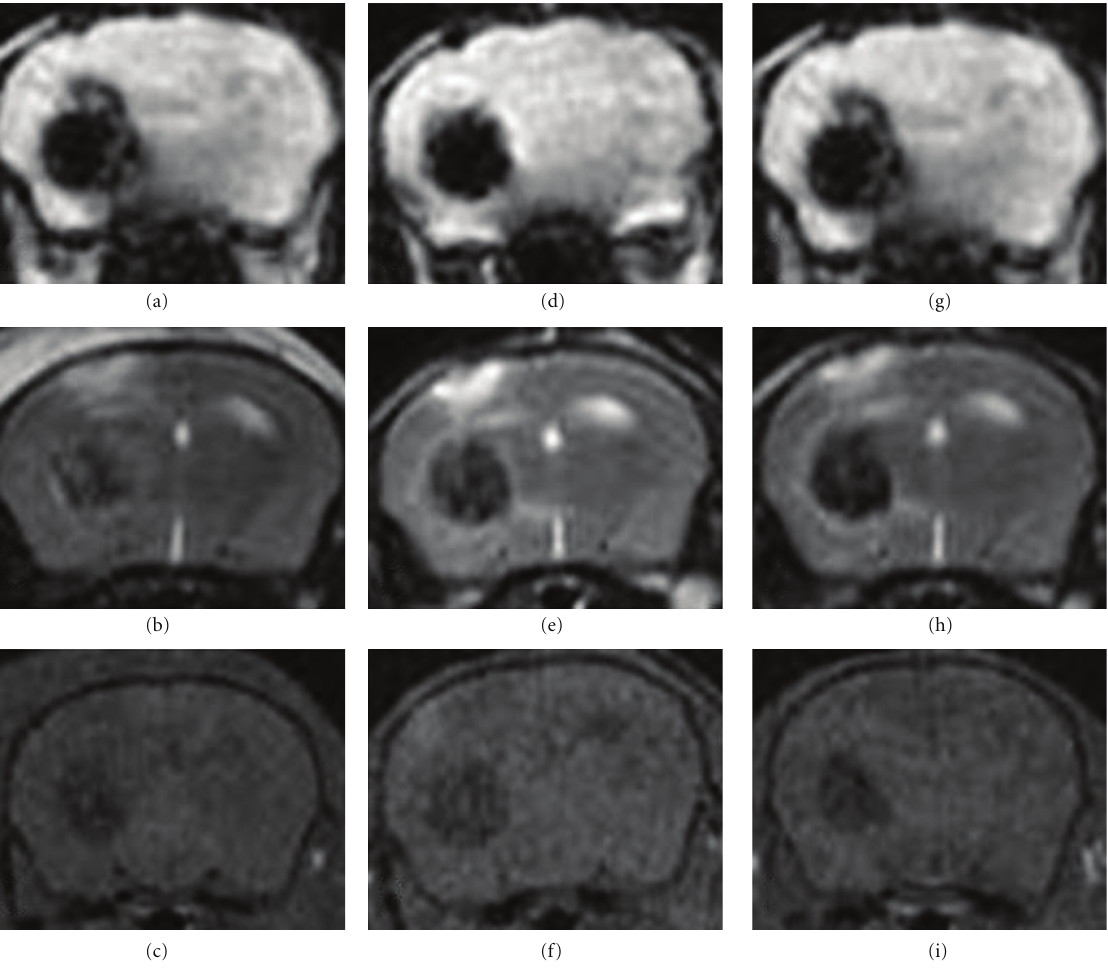
Figure 1: MR tomographic images on 4.7 T using T2 ∗ - (a, d, and g), T2- (b, e, and h), and T1-weighted images (c, f, and i) in a mouse 2 (a–c), 8 (d–f), and 24 hours (g–i) after stereotactic collagenase injection. The hematoma appears hypointense on T1 as early as 2 hours after collagenase injection and does not change in signal intensity and homogeneity over the first 24 hours. The blooming e ff ect of T2 ∗ -weighted sequences makes the hematoma appear larger and needs referencing with T1- and T2-weighted images. T2-weighted images reveal a rim of hyperintensity surrounding the hypointense core as early as 8 hours. There is no evidence of hematoma enlargement over the first 24